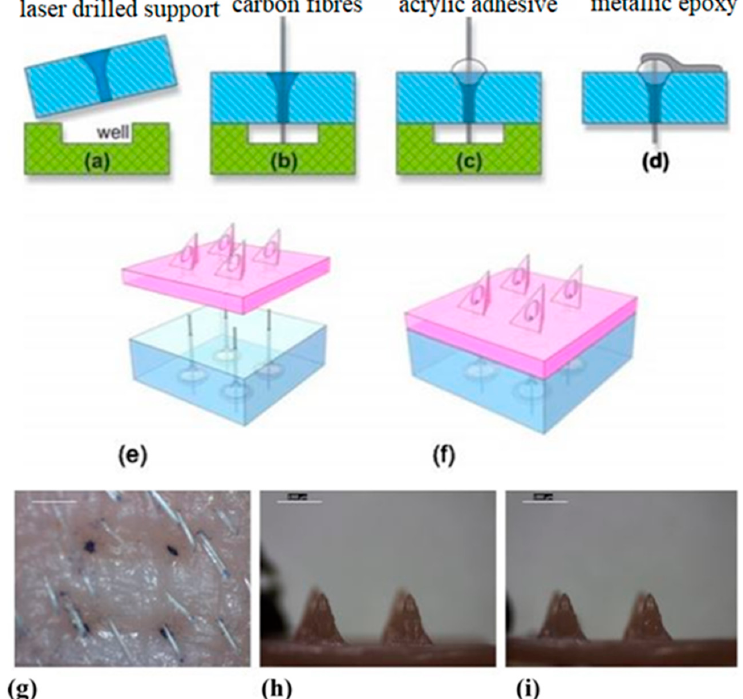
Figure 14. Schematic showing steps ( a ) – ( f ) used for assembly of the microneedle device. Images of microneedle array and cadaveric porcine skin after microneedle insertion. ( g ) Optical micrograph showing delivery of trypan blue into microneedle-fabricated pores within cadaveric porcine skin scale bar 1 = mm. ( h ) Optical micrograph showing hollow microneedles before insertion into cadaveric porcine skin. ( i ) Optical micrograph showing hollow microneedles after insertion into cadaveric porcine skin [42].